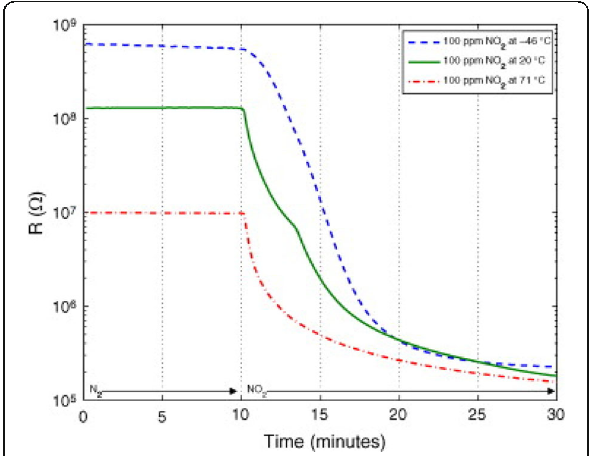
Fig. 15 Response of sensors to 30-min 100 ppm NO 2 exposure (reprinted with permission from Reference Shu et al. 2010). © 2010 Elsevier